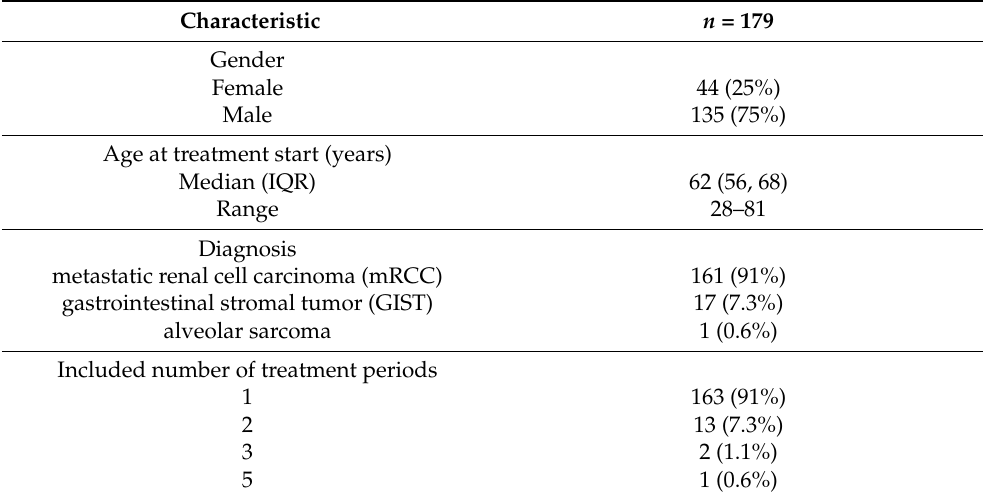
Table 1. Patient characteristics.